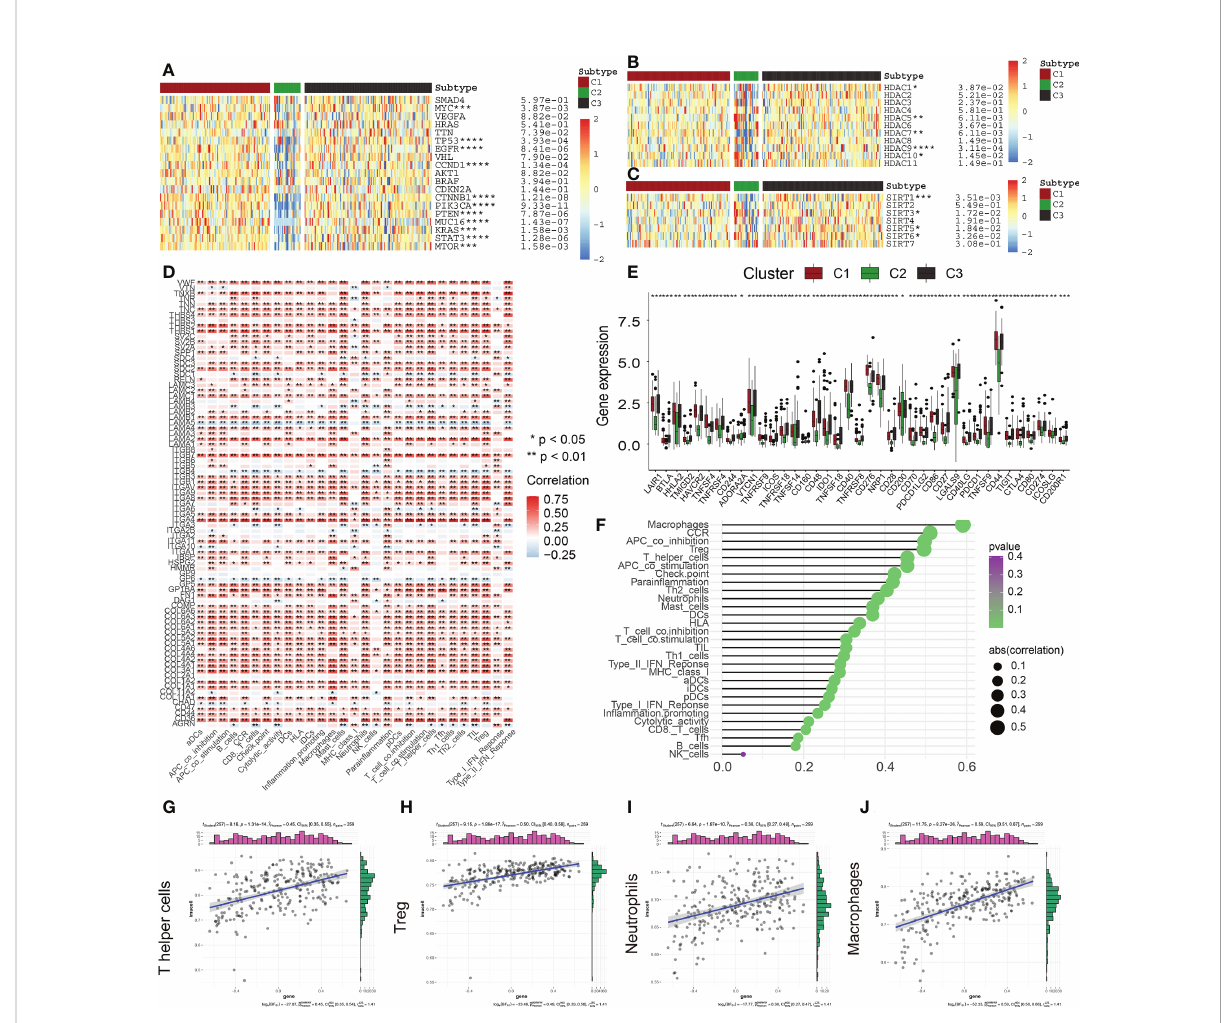
FIGURE 7 Correlation of ECM scores with Classical Oncogenes, Tumor Suppressor Genes, and Immune Cell In fi ltration. (A) Different levels of expression of distinct tumor suppressor genes and oncogenes in 3 ECM clusters. (B) The different levels of HDAC Family Genes expression among three ECM clusters. (C) The different levels of Sirtuin Family Genes expression across the 3 ECM clusters. (D) The heat map depicts the relationship between ECM-associated genes and in fi ltration levels of immune cells. A positive association is denoted by red, while a negative association is denoted by blue. (E) The different expression levels of immune checkpoints among three ECM clusters. (F) The plot depicts the link between the ECM score and in fi ltration levels of immune cells. The size of the sphere on the right side of the fi gure denotes the degree of abs (correlation), while the color denotes the p-value. (G – J) The scatter plot depicts the relationship of ECM score with 4 immune-in fi ltration-related substances. The ECM score was shown to have a positive link to the in fi ltration levels of neutrophils, macrophages, CCR, Treg cells, and so on. (* indicates p <0.05; ** indicates p < 0.01; *** indicates p < 0.001; **** indicates p <